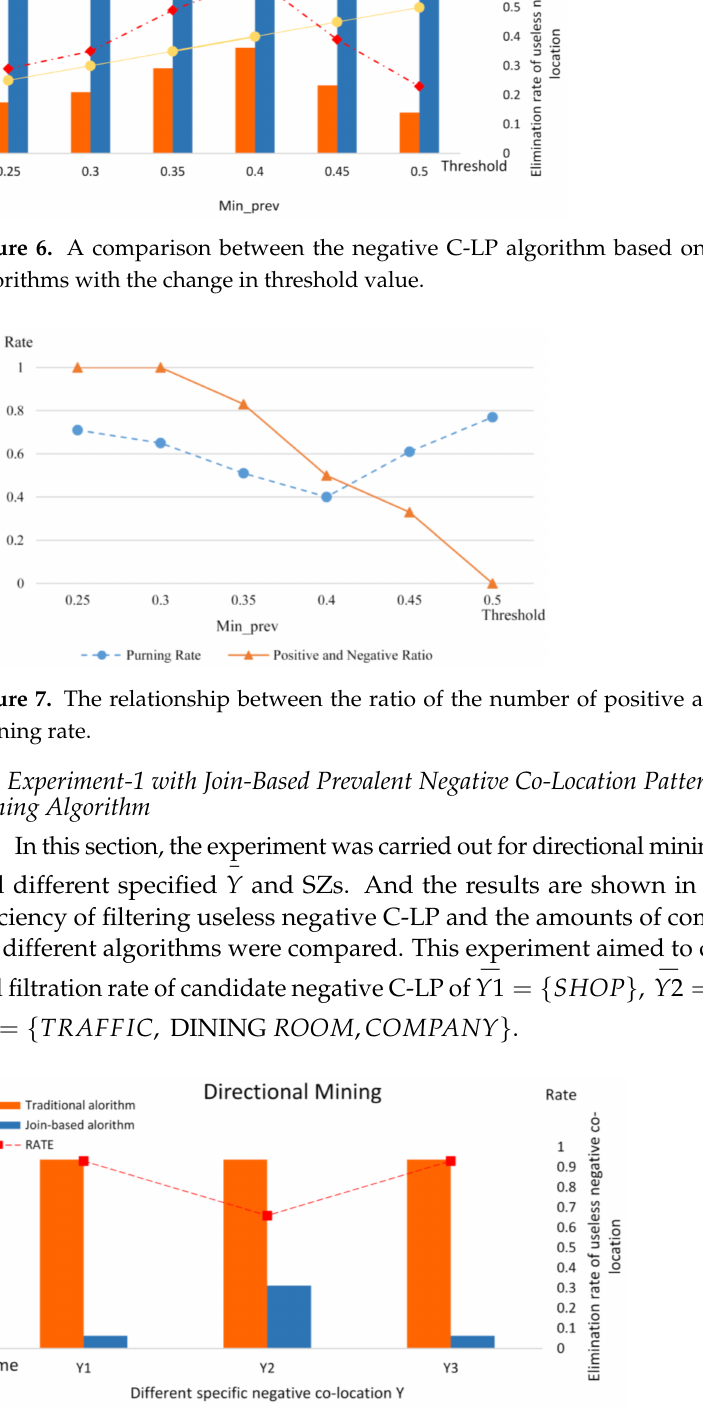
Figure 8. A comparison between the negative C-LP algorithm based on the J-B and traditional – Y and algorithms with the change in